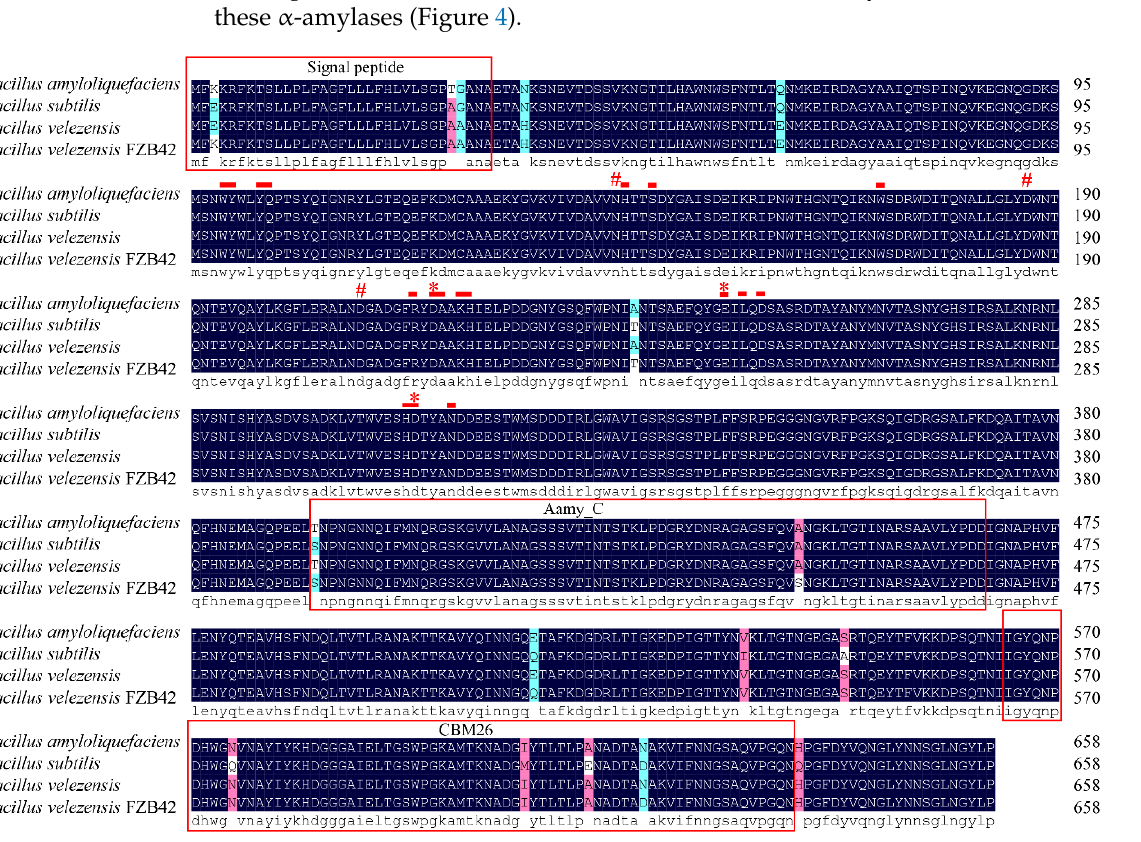
Figure 4. Alignment of BvAmylase and other α -amylase proteins. DNAMAN 7 was used to perform the multi-sequence alignment. The signal peptide (1–33), C-terminal domain alpha-amylase (Aamy_C domain, 393–468), Starch-binding module 26 (CBM26, 565–636) is denoted by the red box. The active sites (99–100, 103–104, 143, 146, 171, 215, 217–218, 220–221, 249, 251, 253, 309–310, 314) are in the red line, the catalytic sites (217, 249, 310) are in asterisk, and Ca 2+ binding sites (142, 187, 212) are in pound sign. Accession numbers for alpha-amylases are Bacillus amyloliquefaciens (WP_174532725.1), Bacillus subtilis (AFD33644.1), Bacillus velezensis (MW822009, WangLB), and Bacillus velezensis FZB42 (WP_095273266.1).